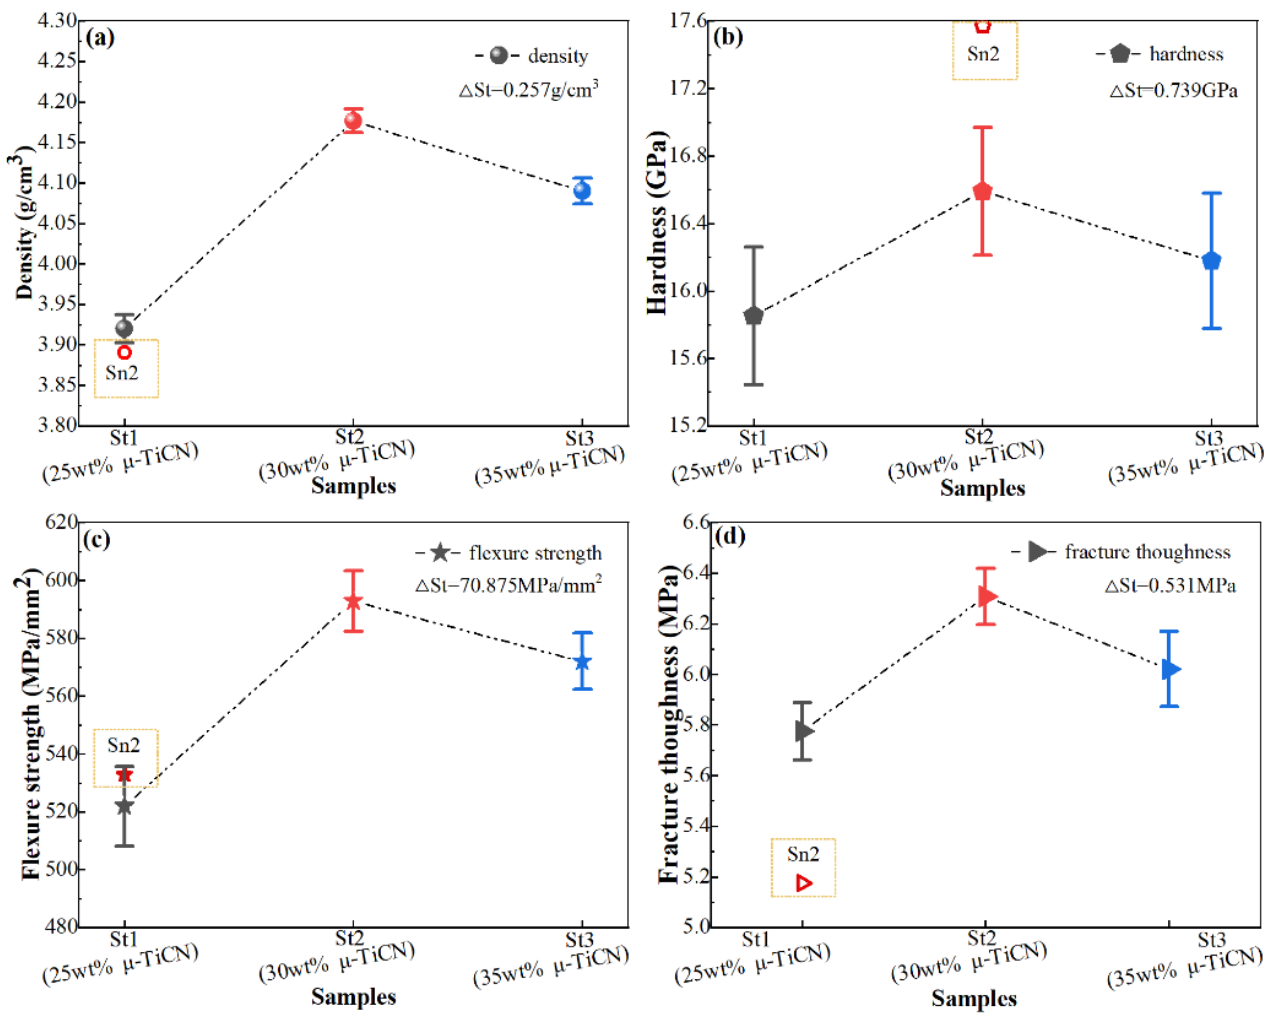
Figure 5. The effects of μ -TiCN on the mechanical properties of St-x type ceramics: ( a ) density, ( b ) hardness, ( c ) flexure strength, ( d ) fracture toughness. ( b ) hardness, ( c ) flexure strength, ( d ) fracture